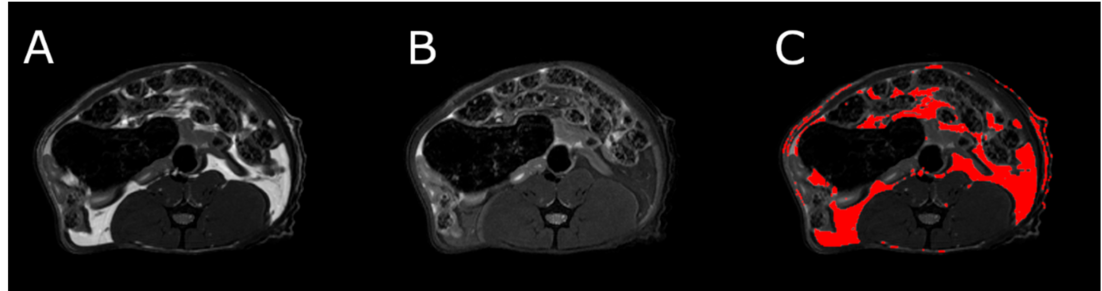
Figure 5. MRI scan of female healthy rat, the cross section of the abdomen at L4 level. ( A ) RARE image without fat suppression; ( B ) fsupRARE image with fat suppression; ( C ) segmentation result—adipose tissue marked in red.